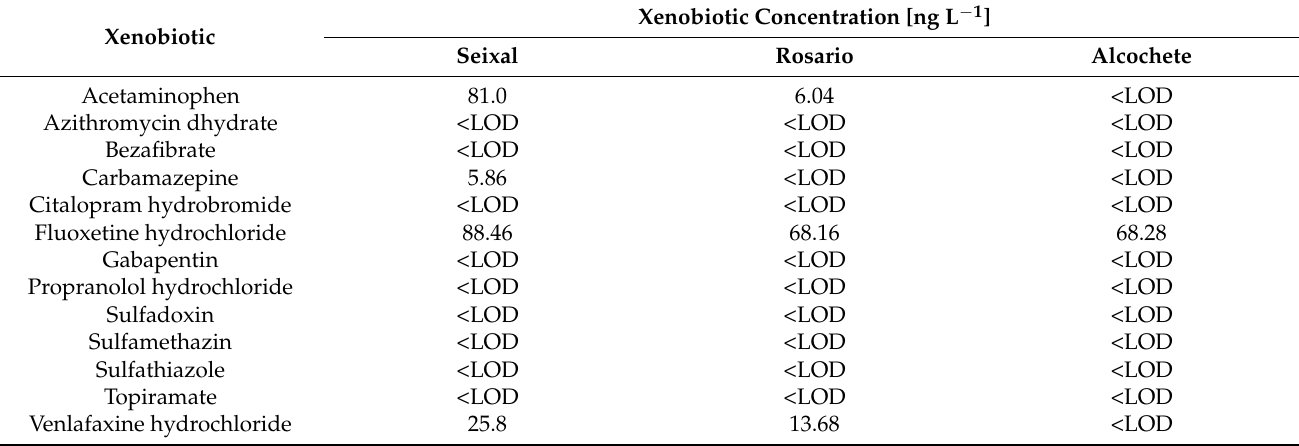
Table 2. Xenobiotic concentration in the water samples from the different sampling sites in Tejo estuary,